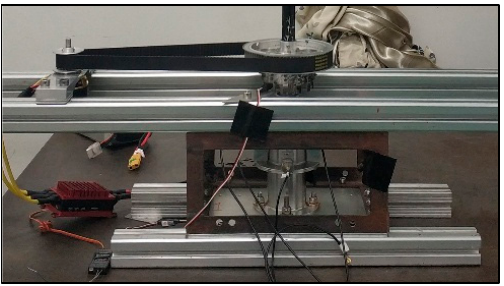
Figure 2. Local view of the belt transmission, Hall-effect speed sensor, and acceleration sensor.